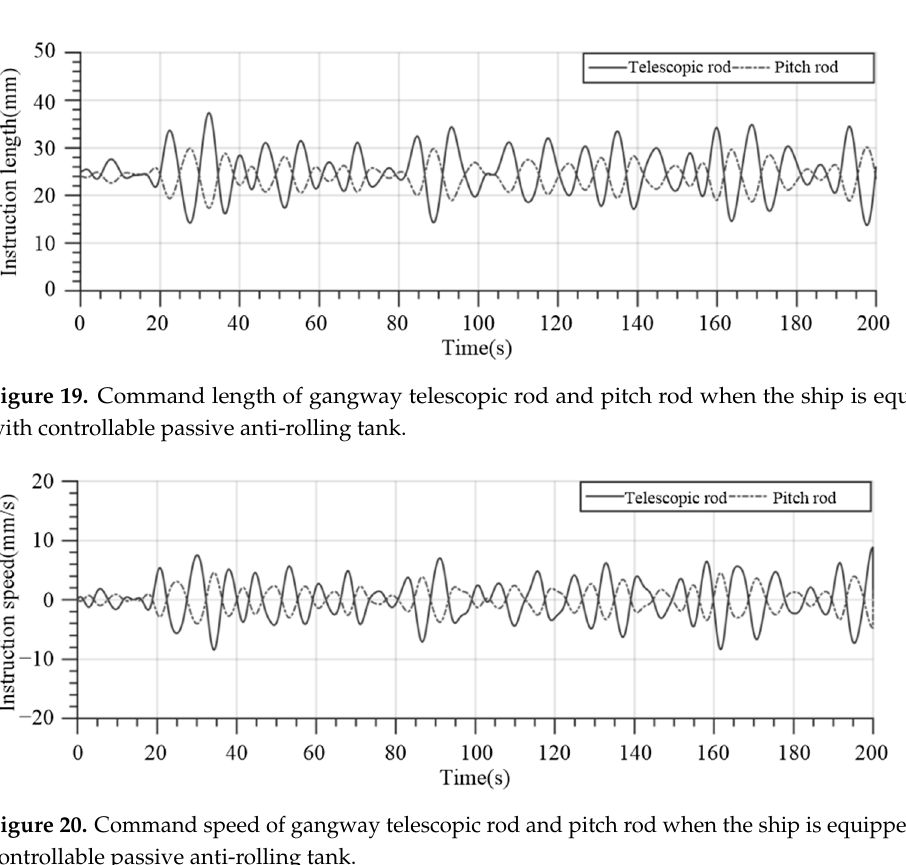
Figure 18. Command speed of gangway telescopic rod and pitch rod when the ship is equipped with passive anti-rolling tank.